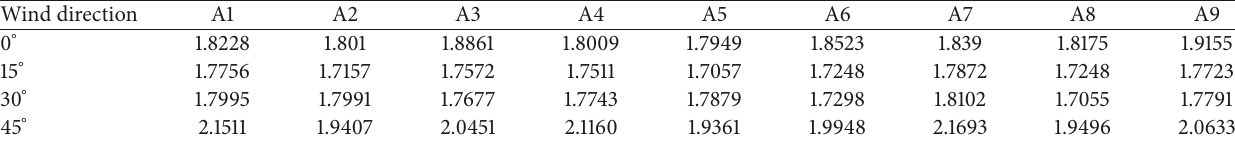
Table 2: Displacement vibration coefficients of points on surface A.